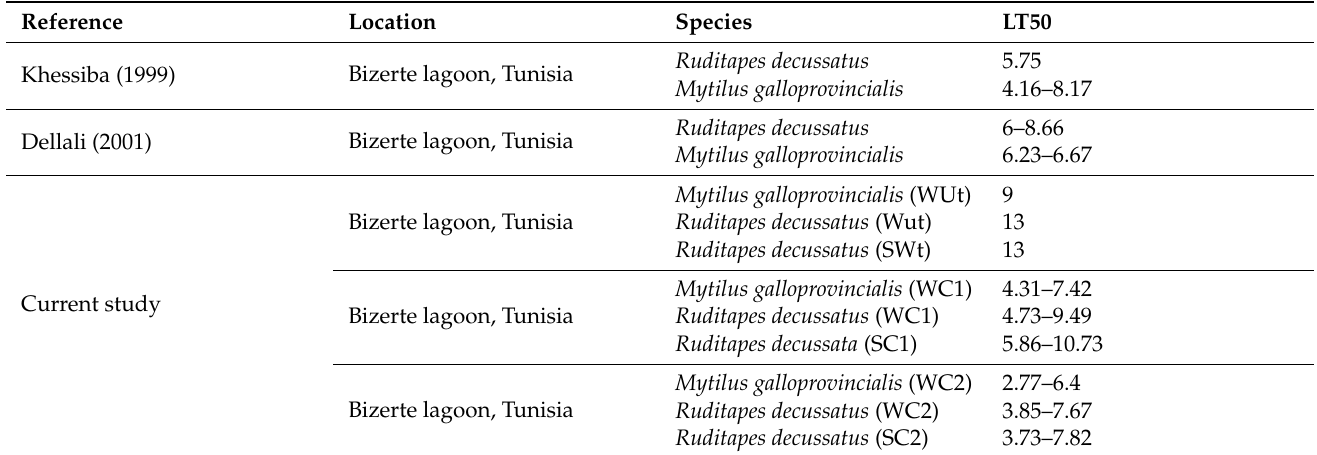
Table 3. Comparison with data from literature on Median Lethal Time of 50% (LT50) of the popu- lations of Mytilus galloprovincialis and Ruditapes decussatus after exposure to two concentrations of phenanthrene in water [50 µ g/L (WC1) and 100 µ g/L (WC2)] and sediment [50 µ g/kg (SC1) and 100 µ g/kg (SC2)] over 28